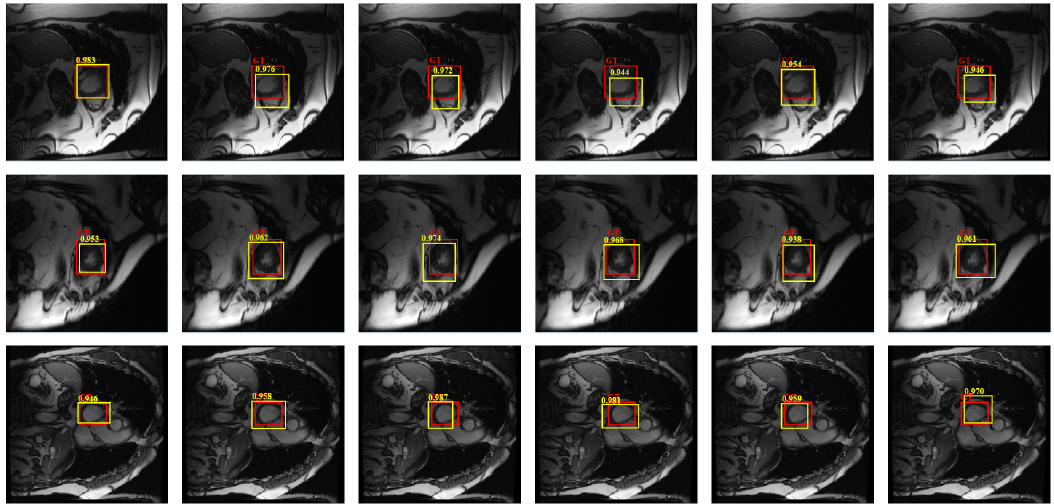
Figure 8. Detection results of our model with different parts, where red rectangles denote ground-truth and yellow ones denote results by compared methods. Each row from left to right: Our model; our model with SLIC; our model with intensity; our model with Softmax; our model with C -SVM; our model with linear regression,